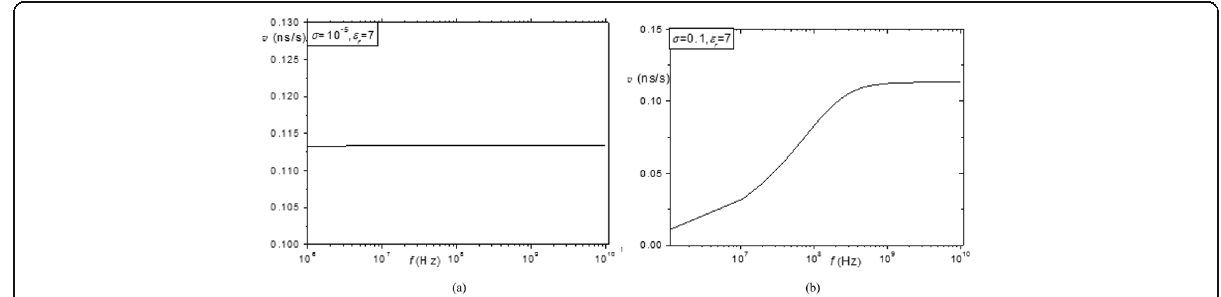
Fig. 4 Changes of the transmission speed of electromagnetic waves vary with frequency. a v-f changes under minor and b v-f changes under